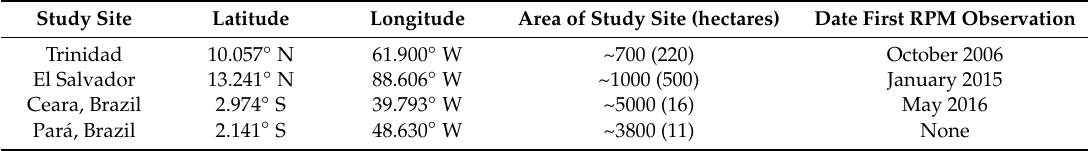
Table 1. Location and characteristics of study sites. Area of study site indicates total palm orchard size in the region, and () indicates the size of the particular domain for which the statistics were